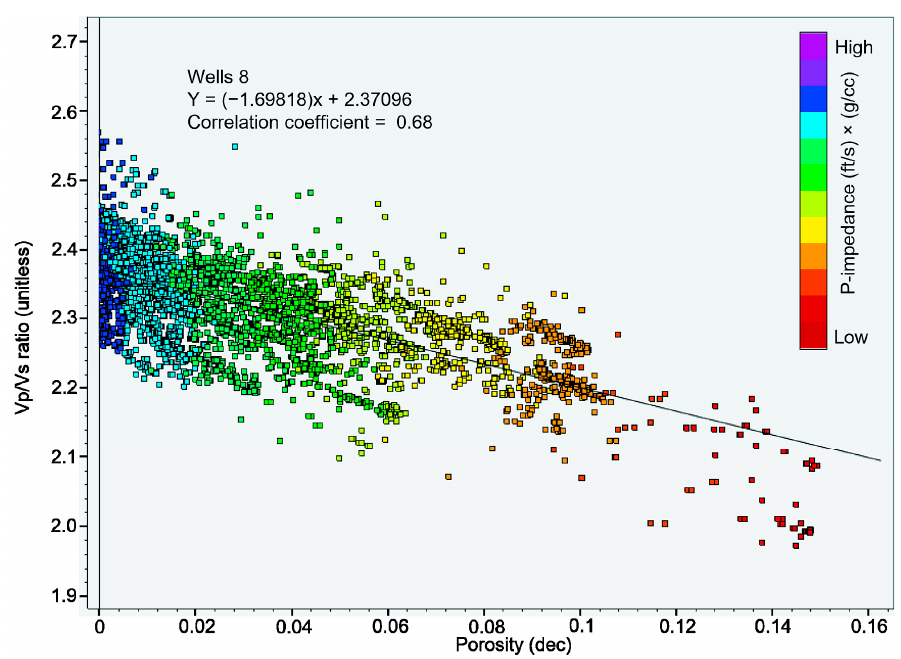
Figure 15. Cross plot of porosity versus Vp/Vs ratio color coded with impedance for wells 4 and 8, showing that Vp/Vs ratio decreases as porosity increases. Note: correlation coefficient = 0.6.